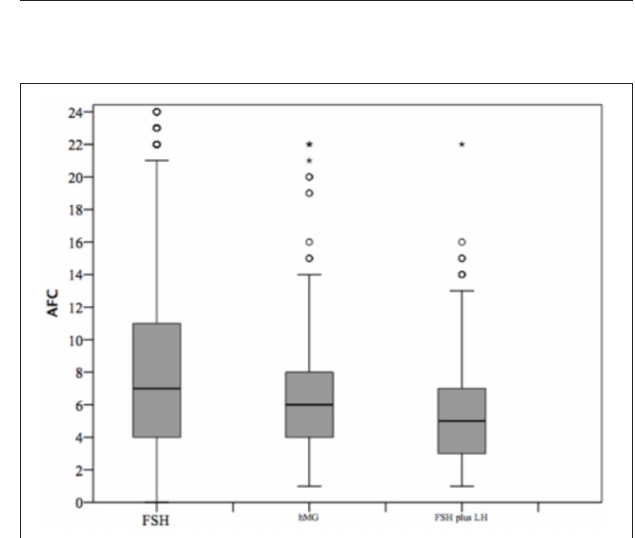
FIGURE 5 | Antral follicle count (AFC) among groups of patients, divided according to gonadotropins regimen chosen. * p < 0.05.